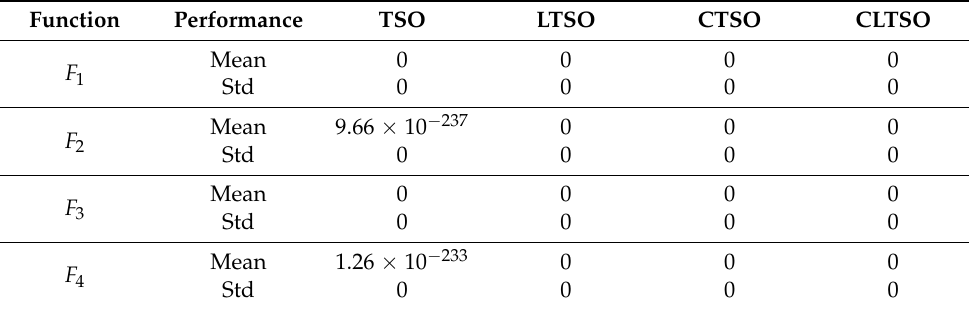
Table 11. Experimental results of various versions of the improved